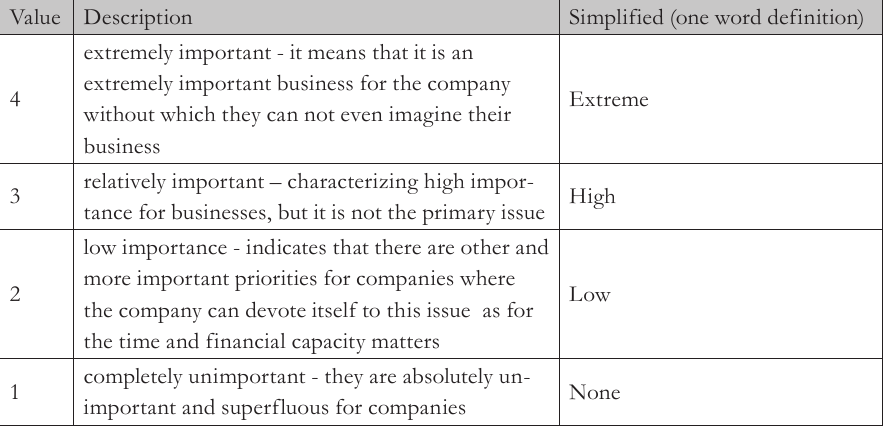
Tab. 2 – Assigned value of the research question and its definition. Source: own